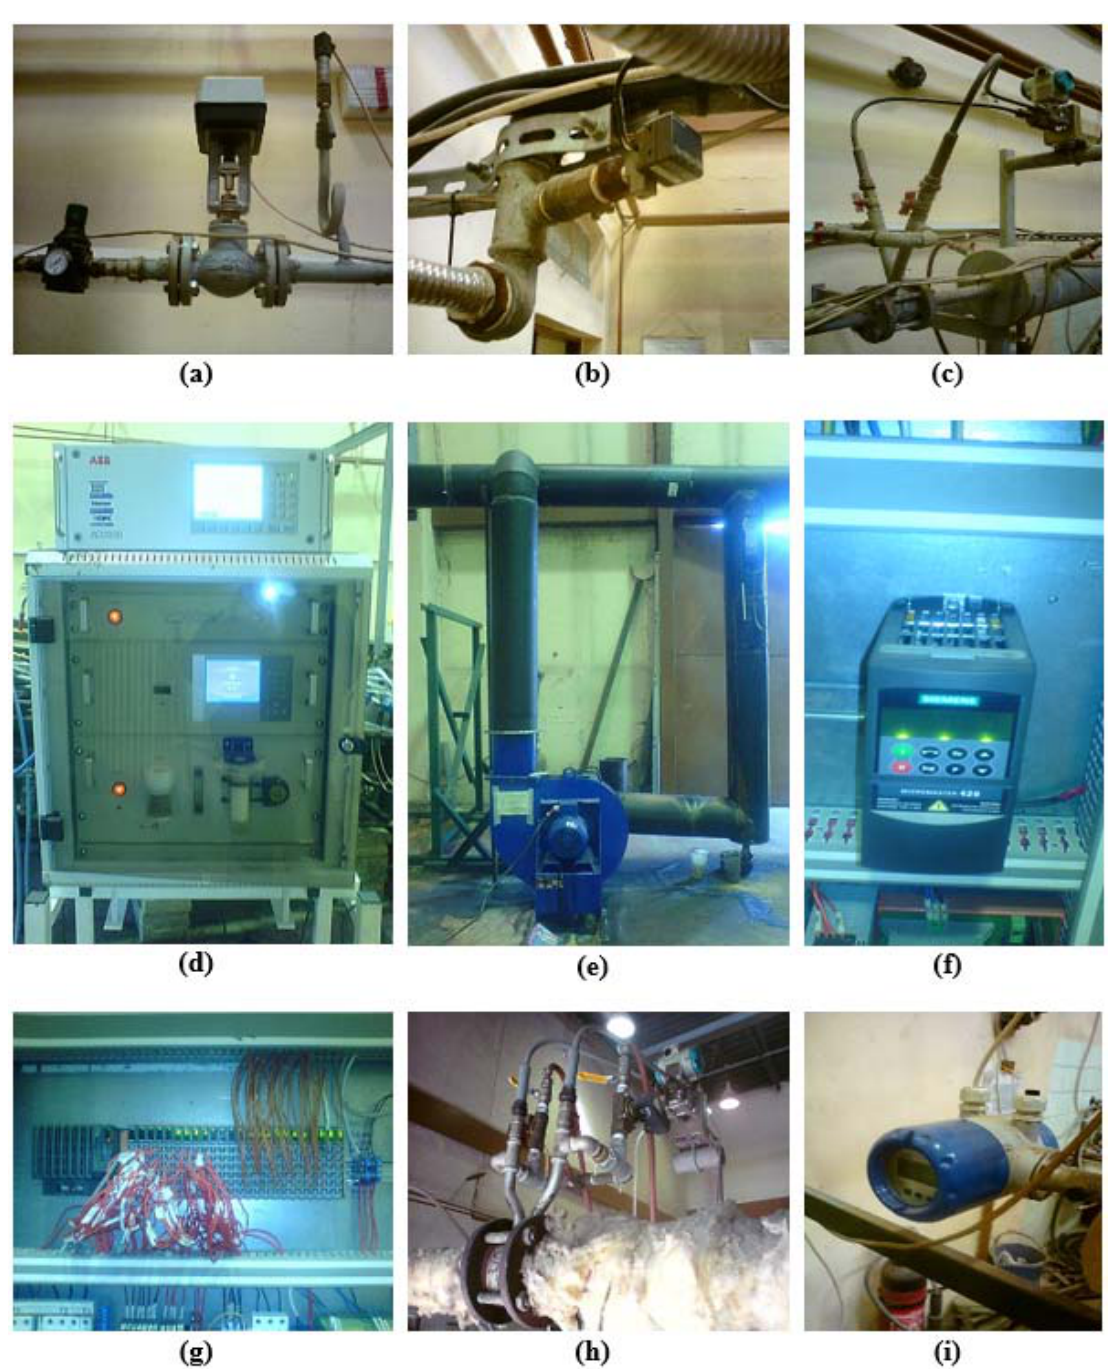
Figure 5. Devices for measurement and control: ( a ) servo valve, ( b ) pressure transducer for air, ( c ) mixing chamber and differential pressure transducer for airflow measurement, ( d ) gas analyzers, ( e ) exhaust ventilator valve, ( f ) frequency changer, ( g ) programmable logic controller (PLC), ( h ) pressure transducer for syngas flow measurement, and ( i ) vortex flow meter for oxygen flow measurement.